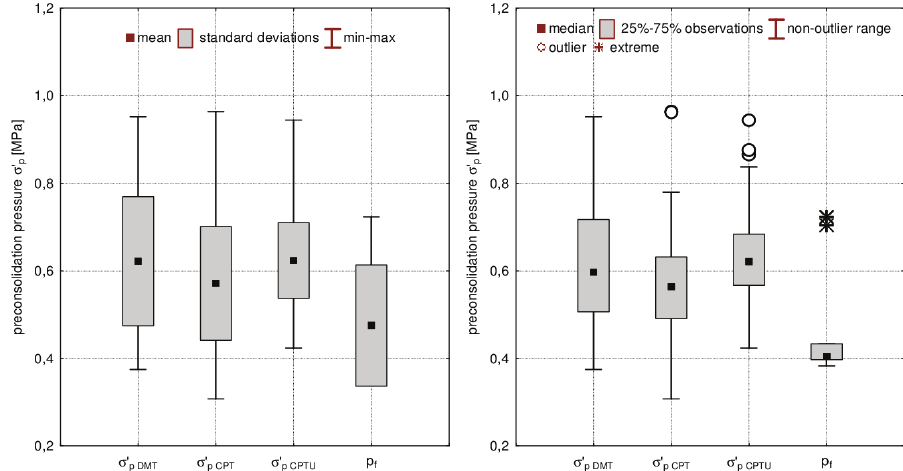
and preconsolidation pressure in the study profile